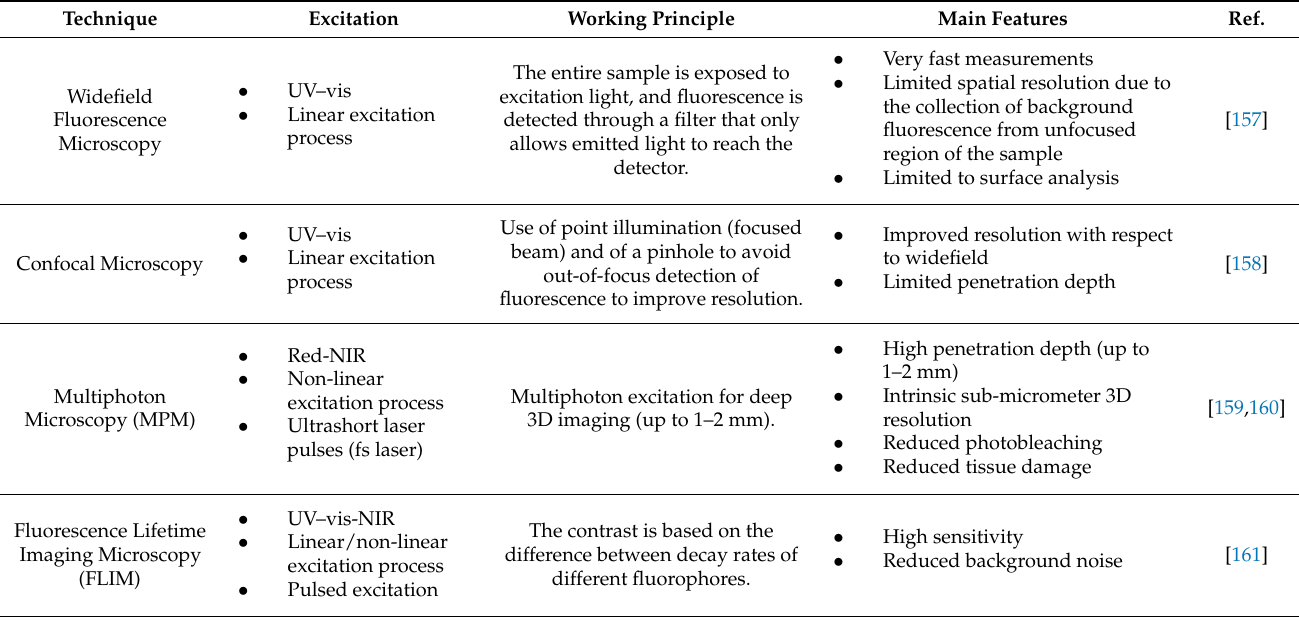
Table 2. Fluorescence imaging